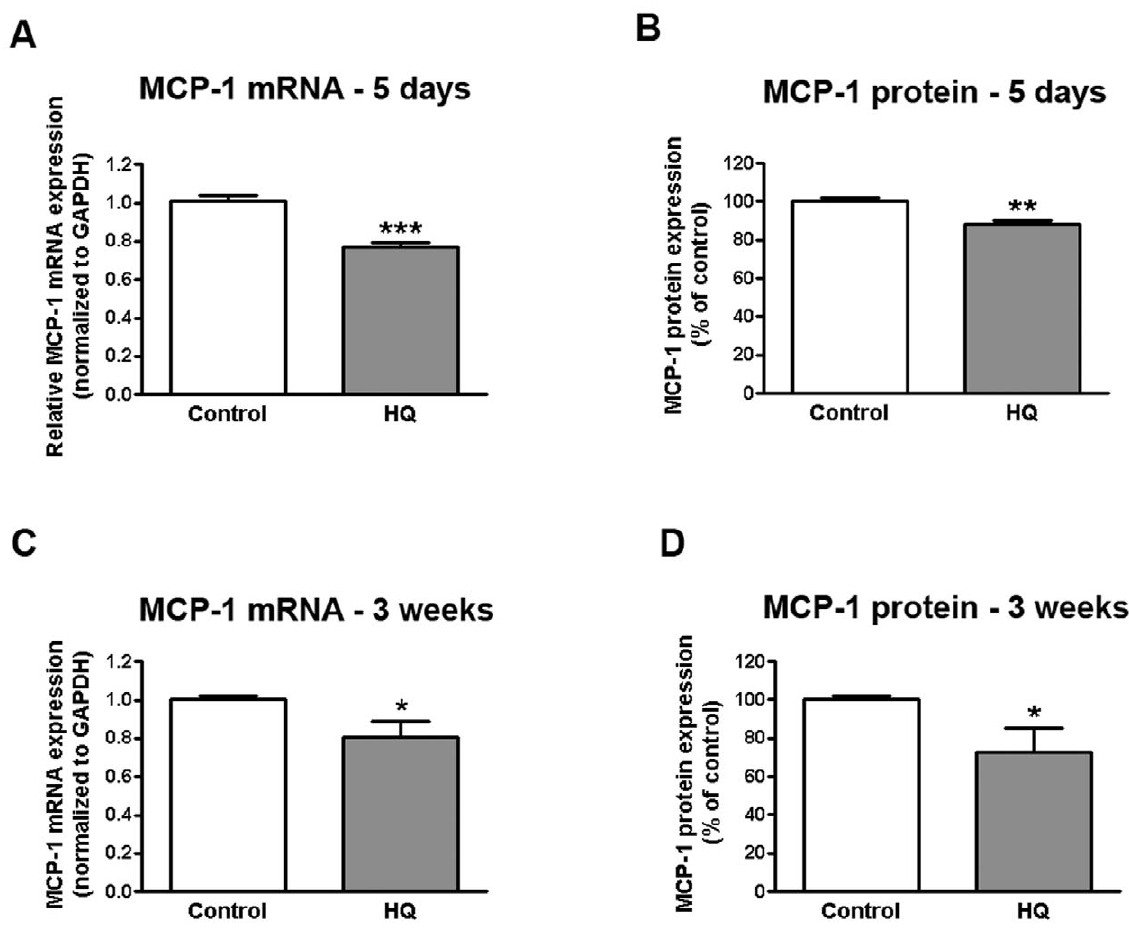
Figure 2. Sustained and repetitive HQ-induced oxidative injury decreases on MCP-1 expression in human RPE cells. Confluent serum- starved ARPE-19 cells were treated with ( A, B ) 10 m M HQ every 24 hours for 5 consecutive days or ( C, D ) 50 m M HQ every 4 days for 24 hours for 3 consecutive weeks in phenol red-free 0.1% FBS medium. Total RNA was extracted to assess MCP-1 mRNA expression by real-time PCR ( A, C ). GAPDH was used as internal control. Supernatants were collected to assess MCP-1 protein concentration by ELISA (B, D). Data are mean 6 SE and represent the average results of 3 independent experiments run in duplicate. * is p , 0.05, ** is p , 0.01 and *** is p , 0.001 versus control.